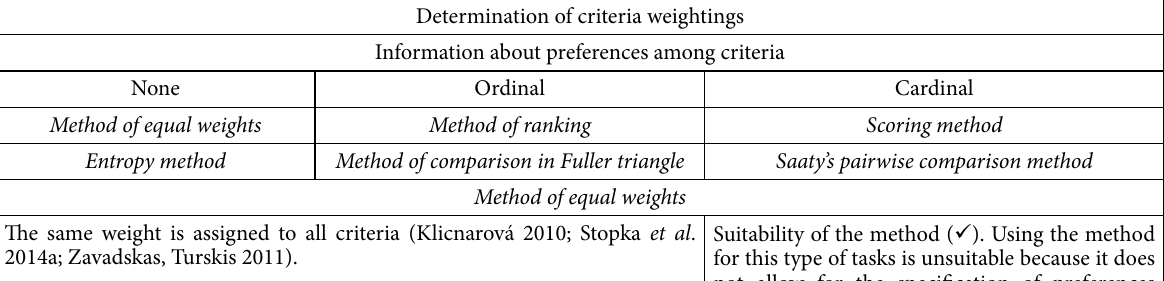
Table 1. Methods for determining the criteria weightings Determination of criteria